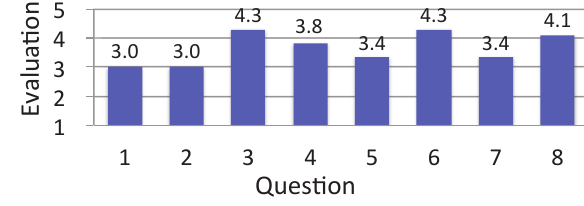
Figure 9. Mean score of each questionnaire item (N =